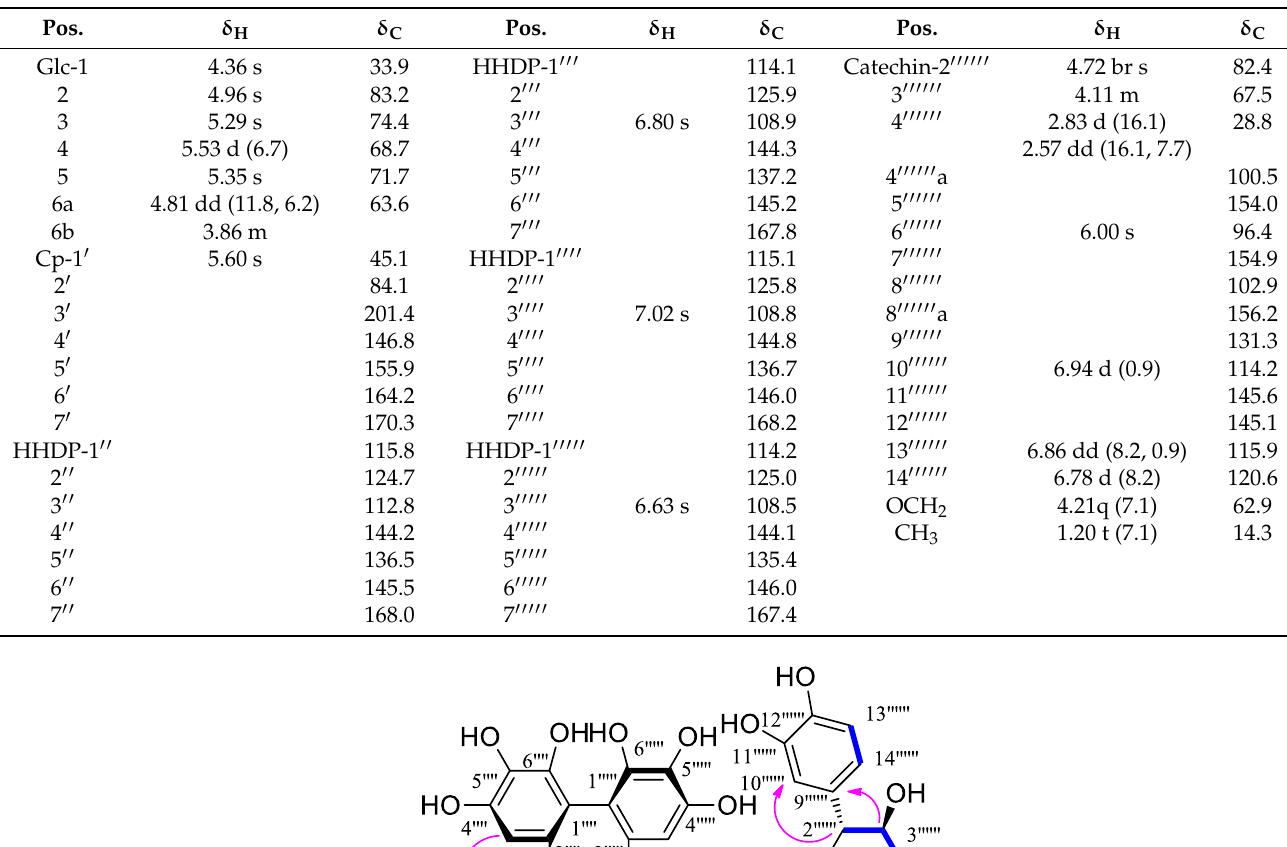
Table 1. 1 H (500 MHz) and 13 C NMR (125 MHz) spectroscopic data for 1 in acetone- d 6 .